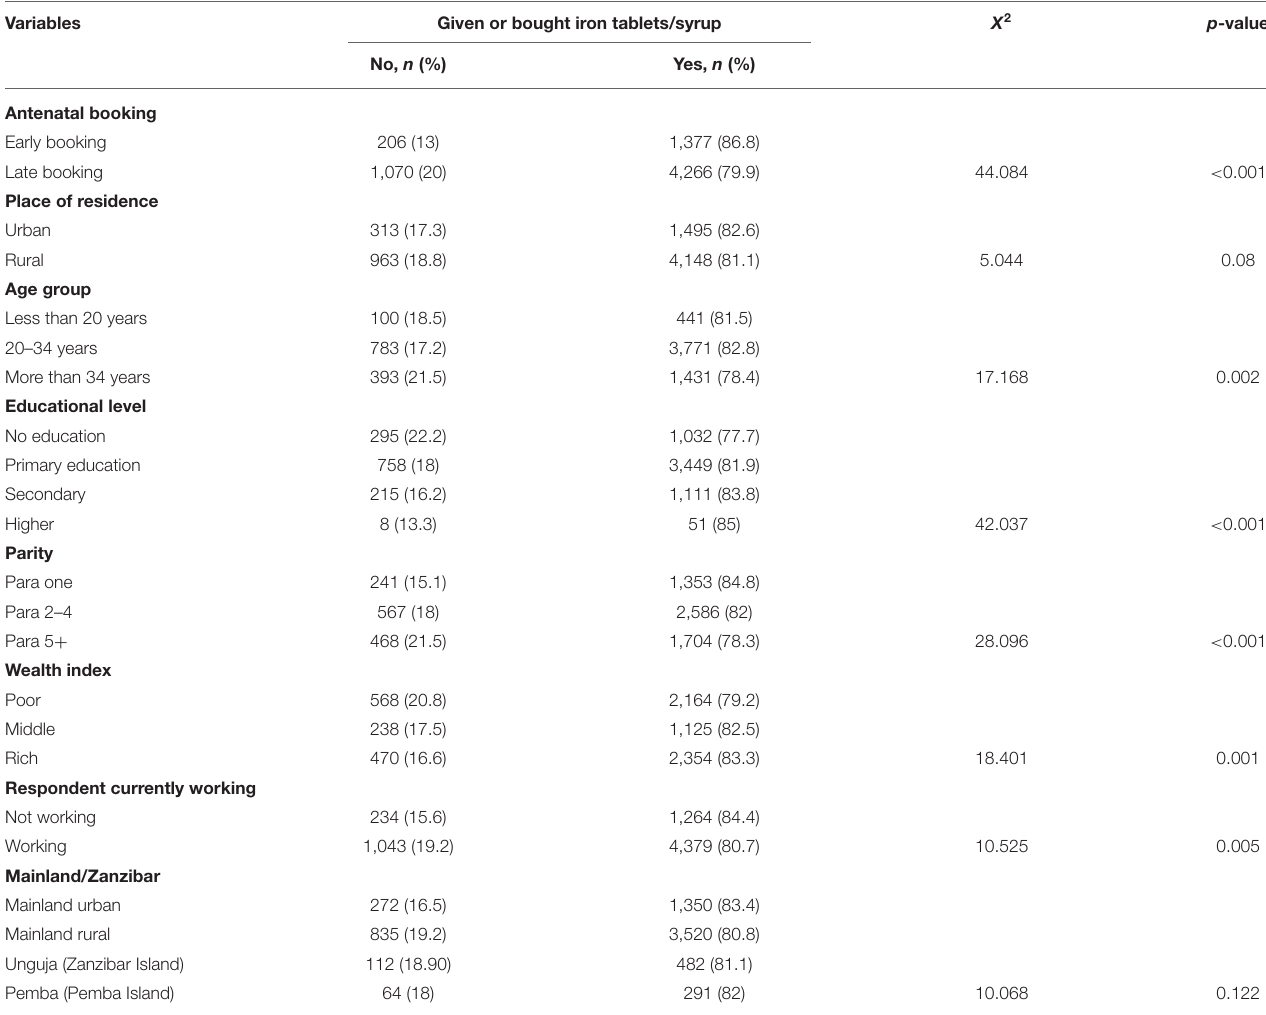
TABLE 2 | The relationship between women’s characteristics and uptake of iron supplement.